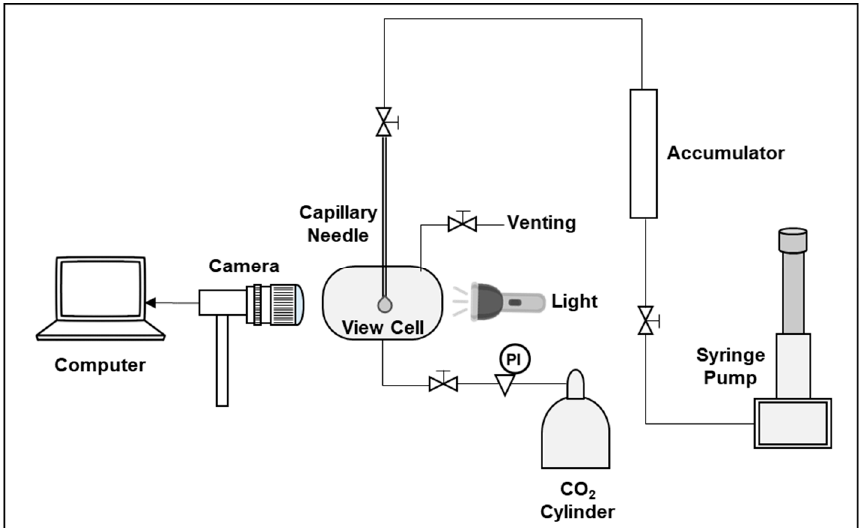
Figure 3. Schematic diagram of the drop shape analyzer setup.